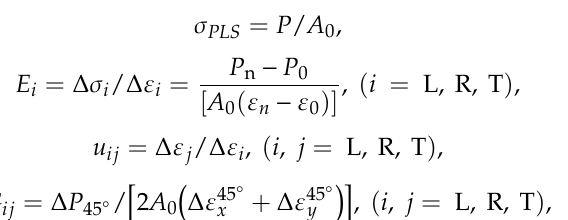
Figure 4. Setup for measuring elastic constants of beech.